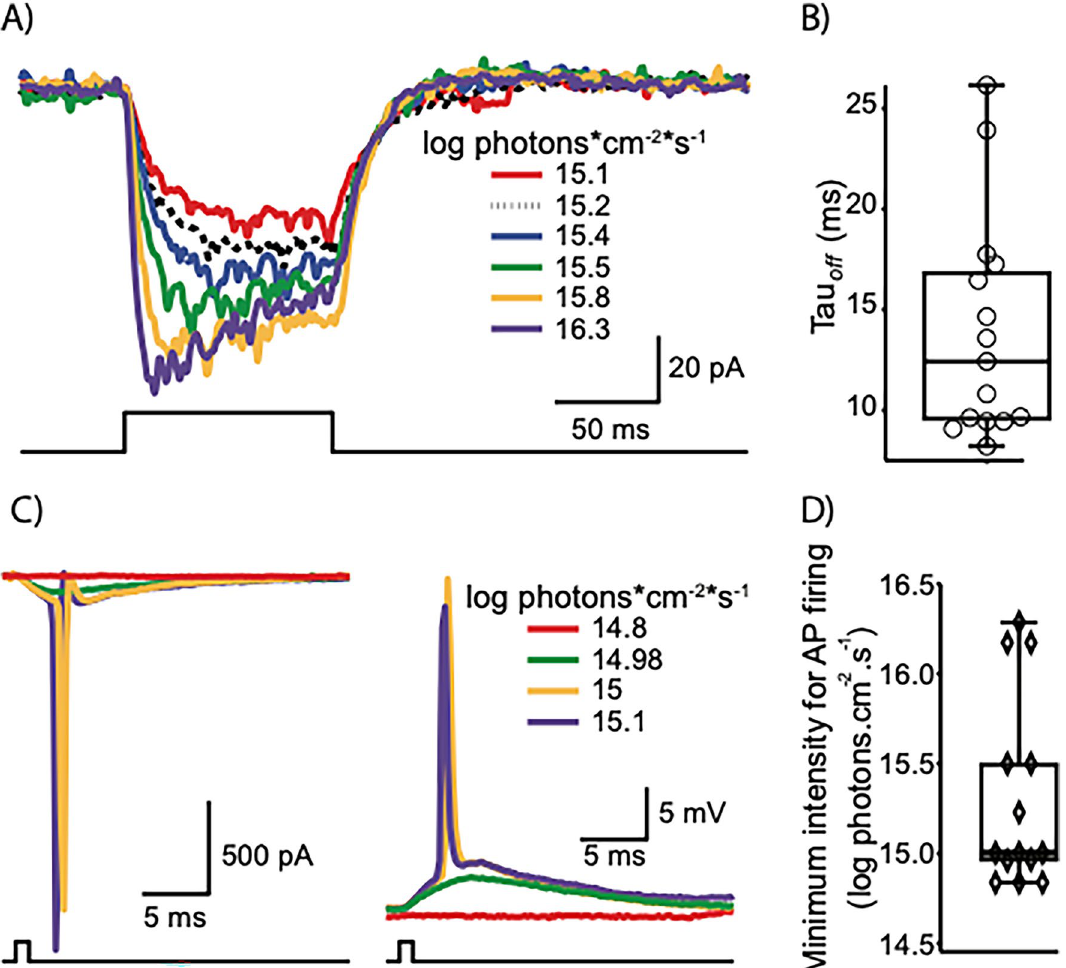
Figure 2. bReaChES expression in dystrophic mouse retina confers novel light sensitivity to RGCs. ( A ) Representative photocurrents recorded from a retinal ganglion cell in response to a 100 ms light pulse at different intensities (15.1 to 16.3 log photons cm 2 s −1 ); a monoexponential function was fit to the tail currents at the end of the light pulse to calculate the off kinetics (τ off ). ( B ) Distribution of τ off quantified in retinal ganglion cells (n = 16) ( C ) Photocurrent (left) and voltage (right) traces elicited by 1 ms pulses of different intensity (14.8 to 15.1 log photons cm 2 s −1 ). Intensities above 14.98 photons cm 2 s −1 generated photocurrents that activated voltage-gated sodium channels, as evidenced by the large, transient inward currents. The amplitude of the voltage response increased with increasing intensities. In this cell, intensities equal to (and above) 15 log photons cm 2 s −1 elicited action potentials. ( D ) Threshold intensity required to elicit an action potential for a 1 ms light pulse (n = 14 cells). All responses were elicited by full-field illumination with λ = 565 nm following bleaching by intense white light (see